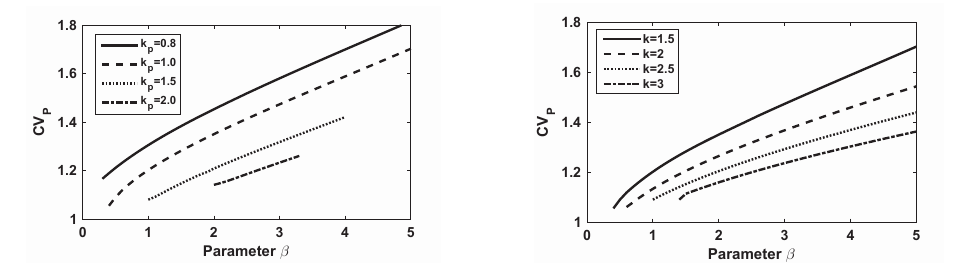
Figure 8. Perturbations in NPZD system lead higher coe ffi cient of variation of phytoplankton CV p drawn at di ff erent parameters (i) k p and (ii) k . In both cases, with higher perturbations higher CV p is quite